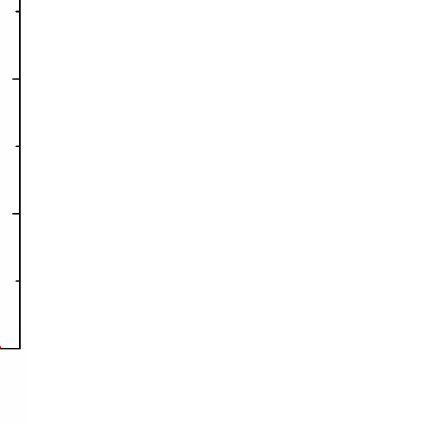
Figure 6. PL spectra of on-axis (lower intensity) and off-axis (higher intensity) samples measured at 6.5